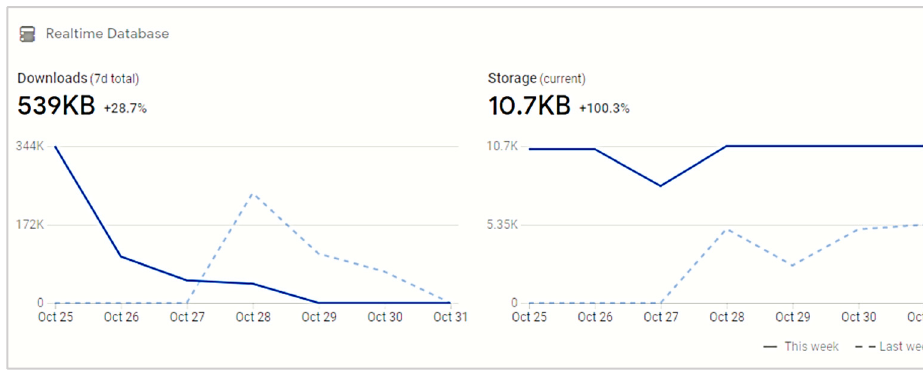
Figure 19. Screenshot of the overview of Zamwallet in the real-time database.